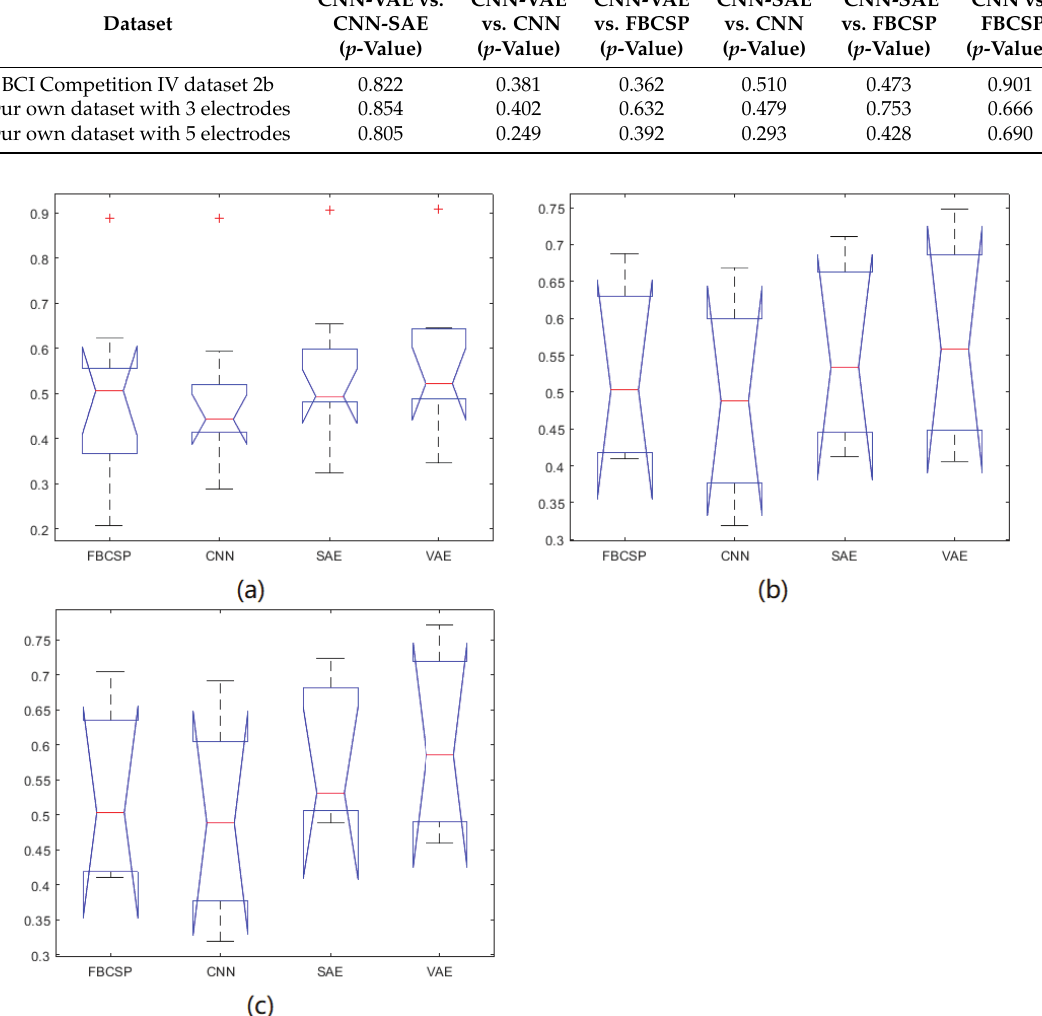
Figure 6. The ANOVA stats of different methods.( a ) is The ANOVA stats of different methods on BCI competition IV dataset 2b; ( b ) is The ANOVA stats of different methods on our own dataset with 3 electrodes; ( c ) is The ANOVA stats of different methods on our own dataset with 5